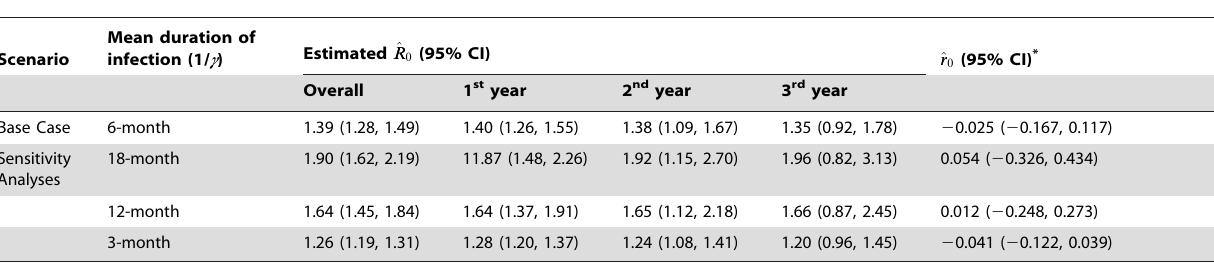
Table 1. Estimated initial reproductive number and the change per year.